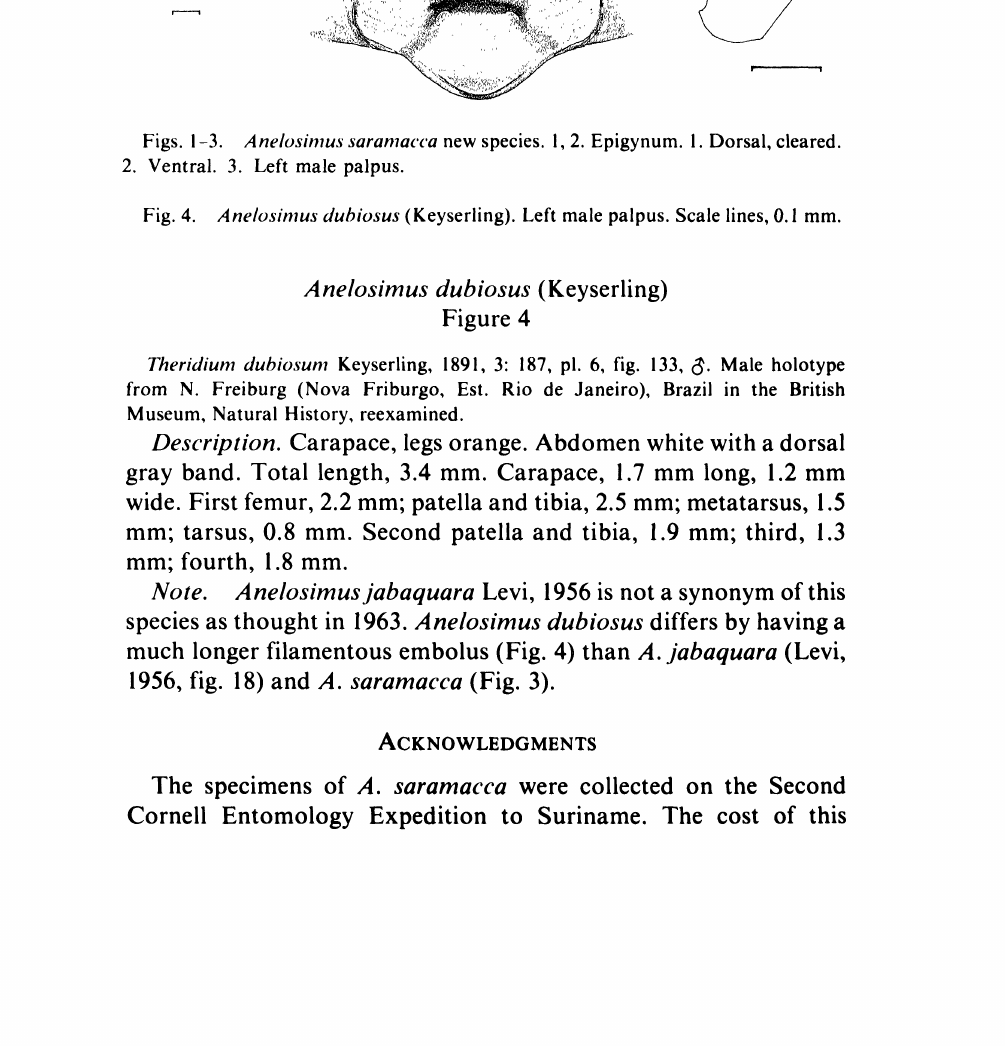
Figs. I-3. Anelosimus saramacca new species. I, 2. Epigynum. 1. Dorsal, cleared. 2. Ventral. 3. Left male palpus. Fig. 4. Anelosimus dubiosus (Keyserling). Left male palpus. Scale lines, 0.1 mm. Anelosimus dubiosus (Keyserling) Figure